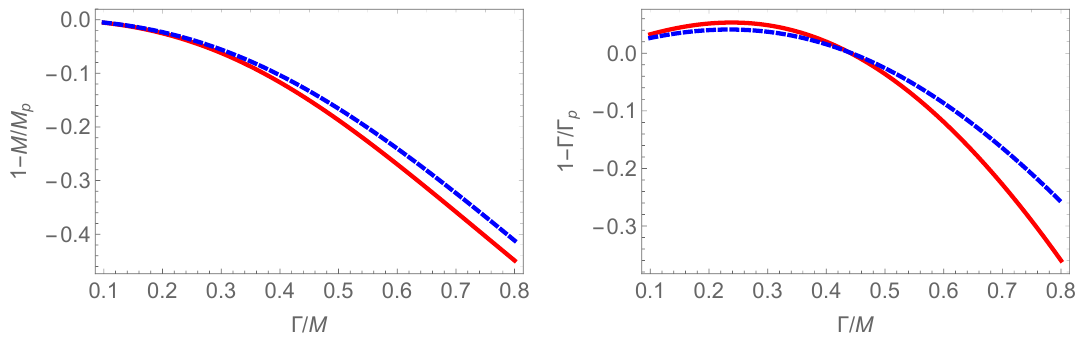
Figure 2 . Plot of 1 − M/M p (left panel) and 1 − Γ / Γ p (right panel) as a function of the ratio Γ /M for two values of the renormalized on-shell mass, M = 1 TeV (solid red lines) and 5 TeV (dashed blue